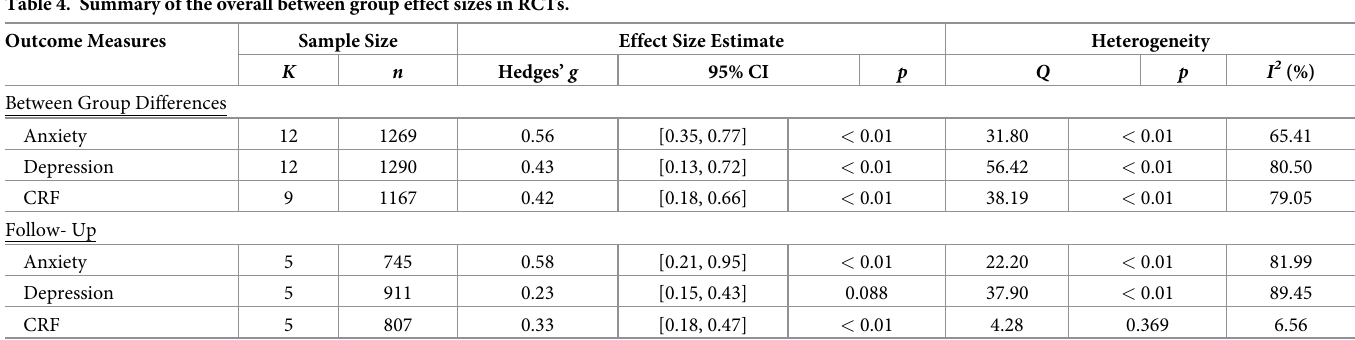
Table 4. Summary of the overall between group effect sizes in